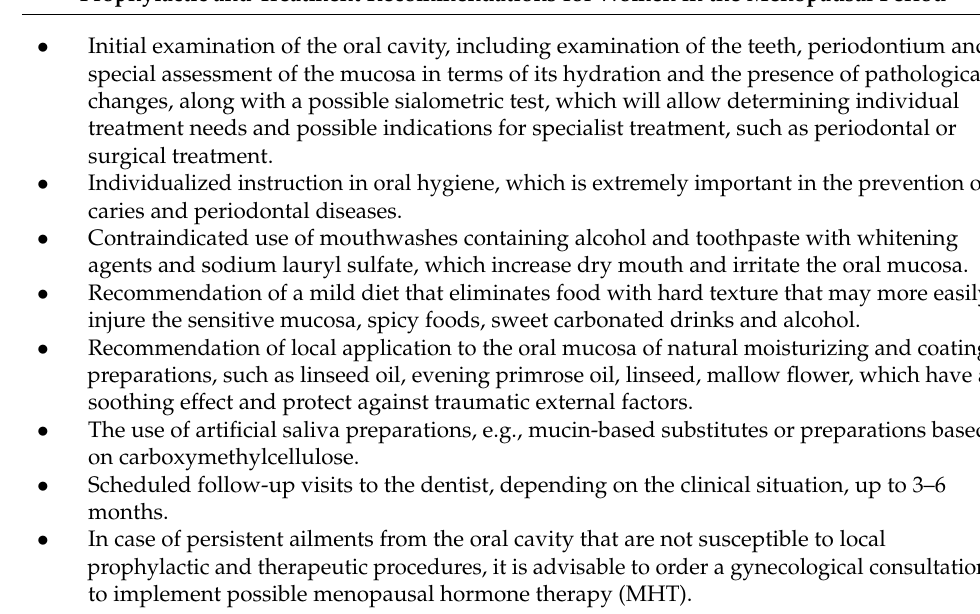
Table 2. Prophylactic and treatment recommendations for women in the menopausal period. Prophylactic and Treatment Recommendations for Women in the Menopausal